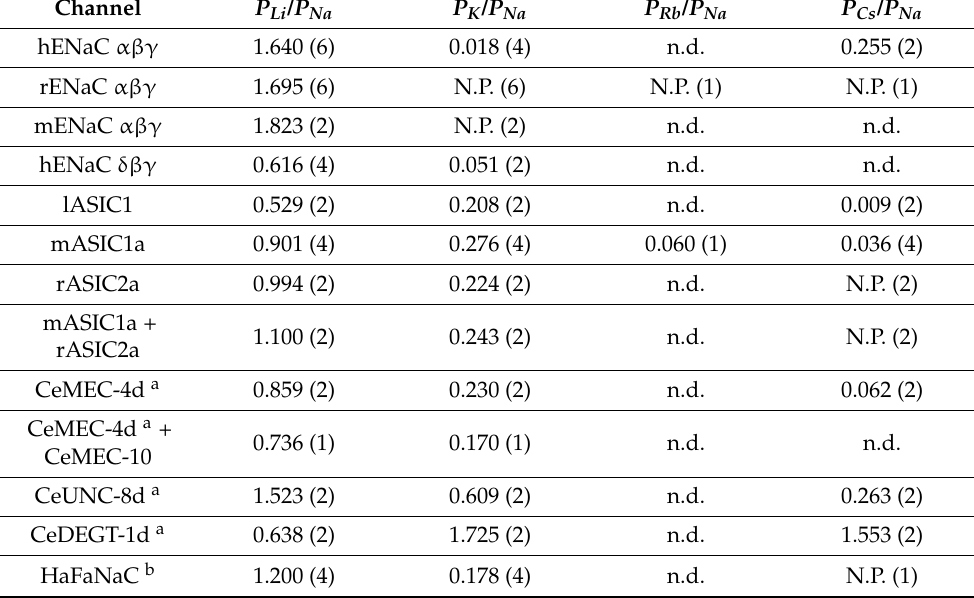
Table 2. Permeability ratios of tested ion over Na + for wt ENaC/DEG channels . Averages of ratios obtained from papers and by calculation. The number of ratios used is shown in brackets. Channel P Li / P Na P K / P Na P Rb / P Na P Cs / P